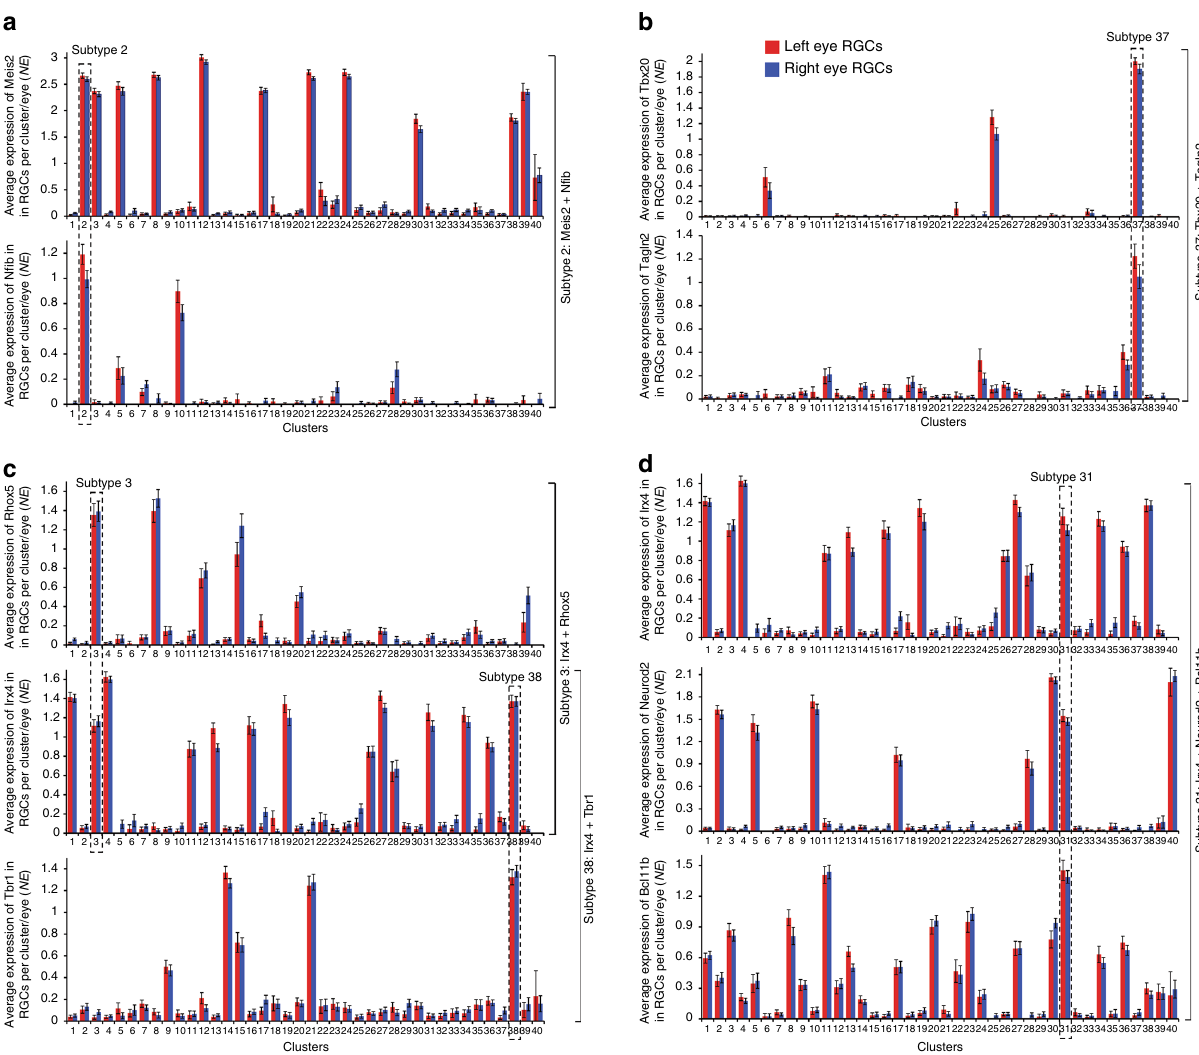
Fig. 8 Examples of RGC subtype-speci fi c TF combinations. a , b 2-way combinations of TFs ( a ), and a TF and transcriptional regulator Tagln2 ( b ), uniquely enriched in RGC subtypes. c Different 2-way TF combinations involving the same TF uniquely enriched in different RGC subtypes. d Three-way TF combination uniquely enriched in an RGC